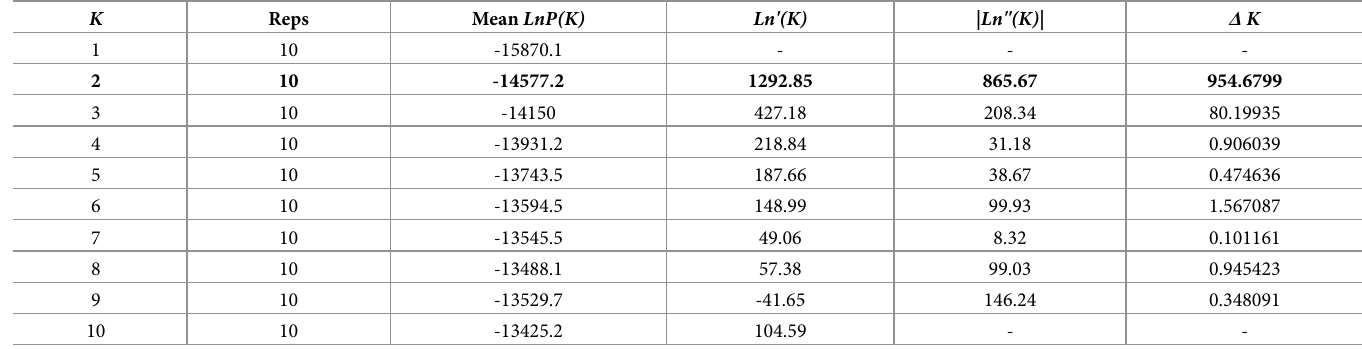
Table 2. Table of four probabilities of model fit implemented with the Evanno method associated with different values of K (i.e., genetic clusters) based on 13 microsatellites implemented in Structure Harvester. Bold text represents the indices that suggests the value of K that best predicts the microsatellite genotypes assigned in the Structure